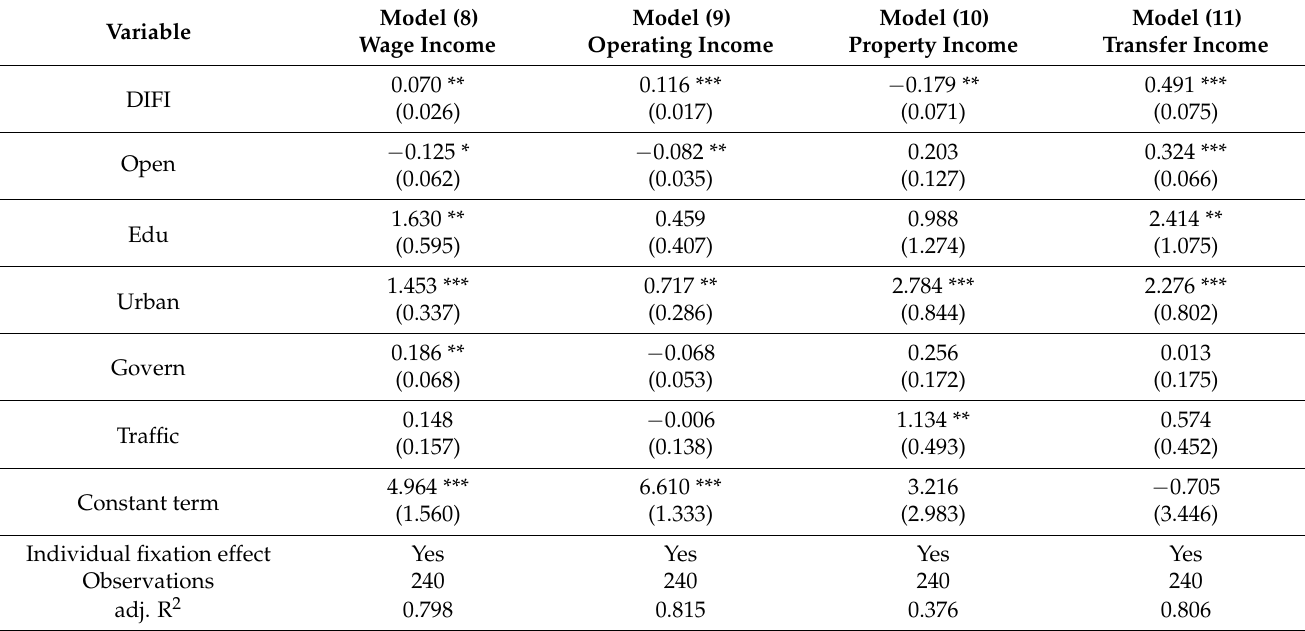
Table 3. Digital inclusive regression results for the four categories of